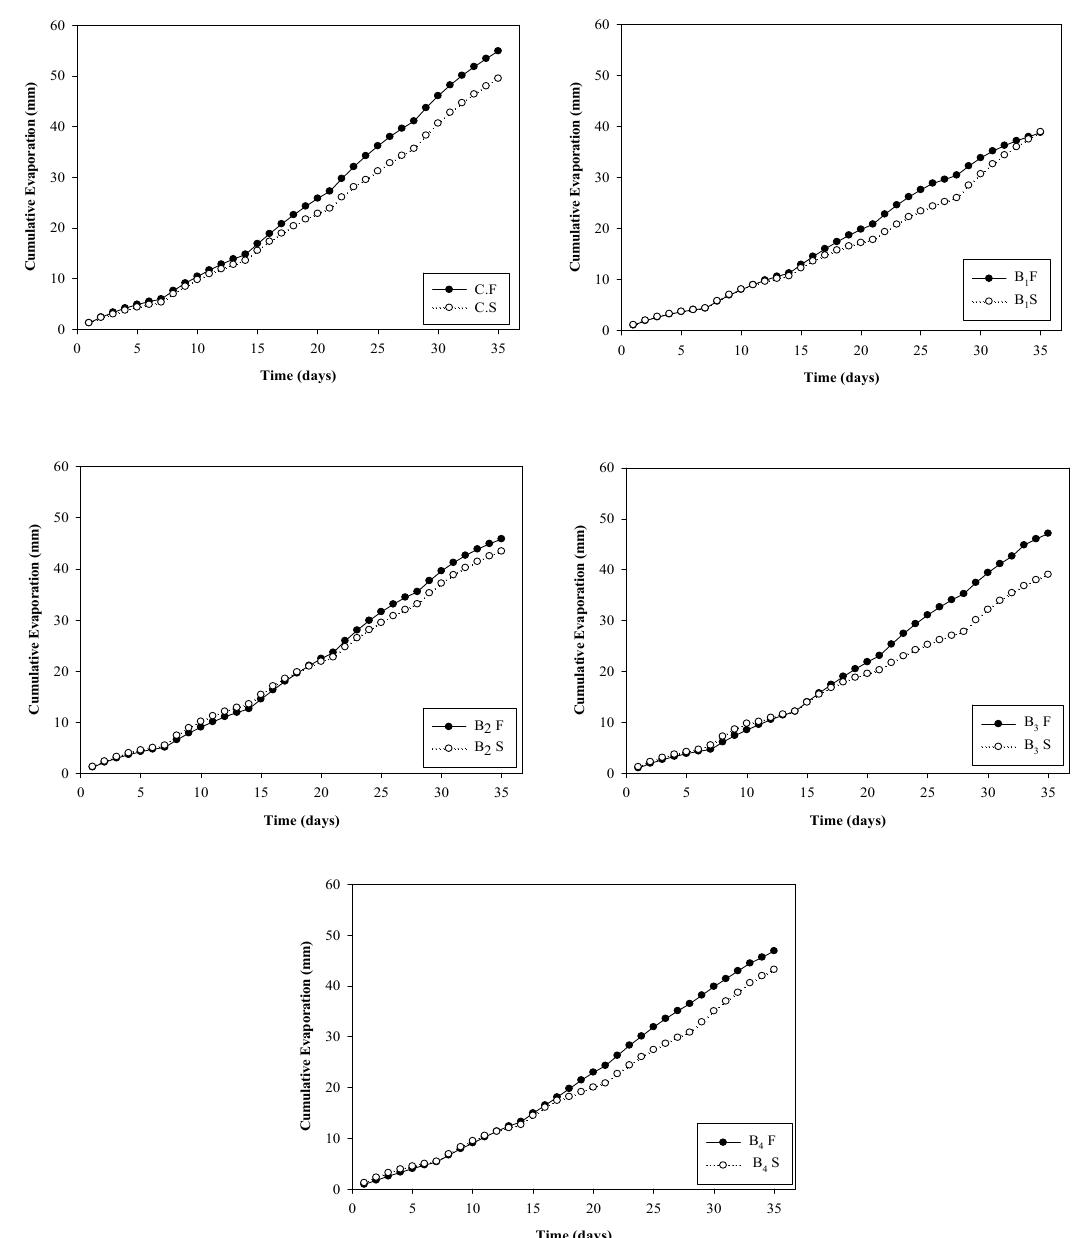
Figure 1. Effect of biochar application on C.E. C denotes the control soil and B denotes the soil with biochar 1, 2, 3, and 4 application rates. F and S denote fresh and saline water, respectively.